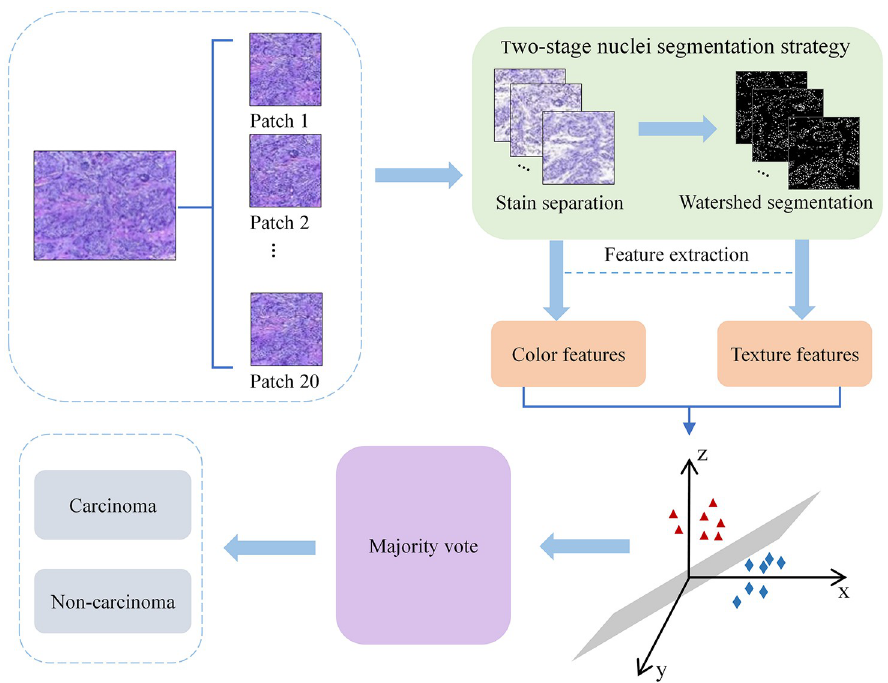
Fig 1. The framework of breast cancer histopathological images recognition based on the two-stage nuclei segmentation strategy proposed in this paper.